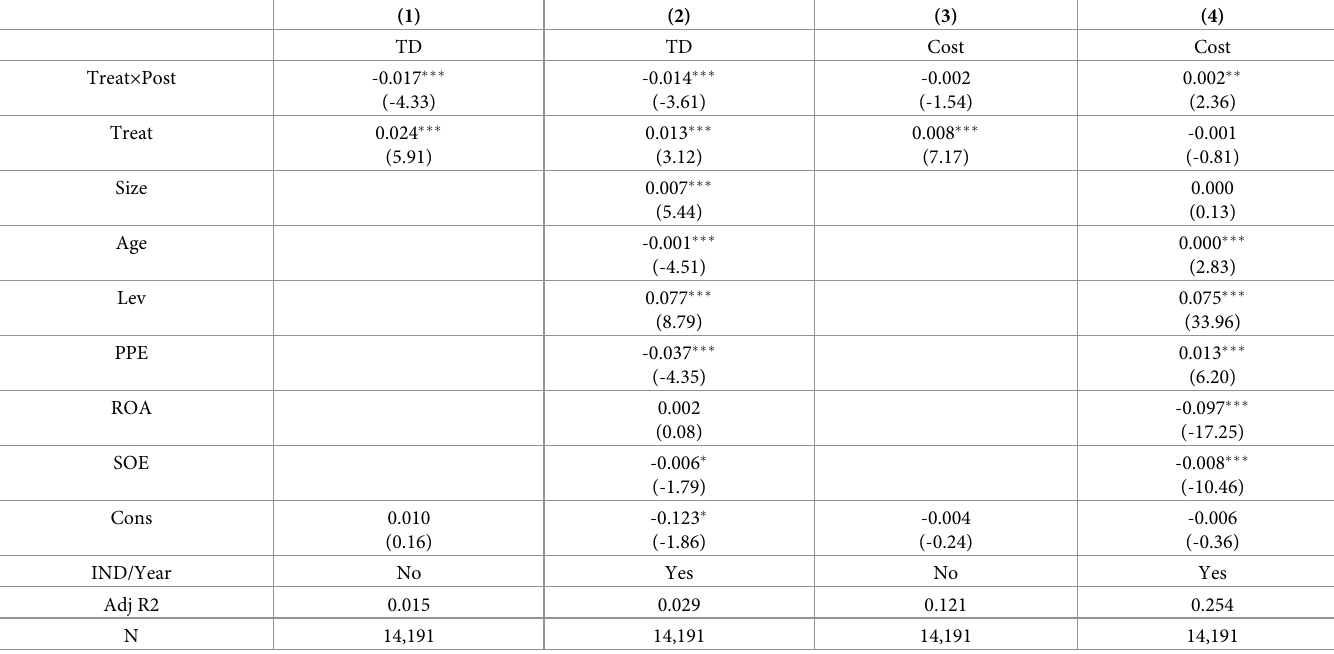
Table 4. Results of multivariate